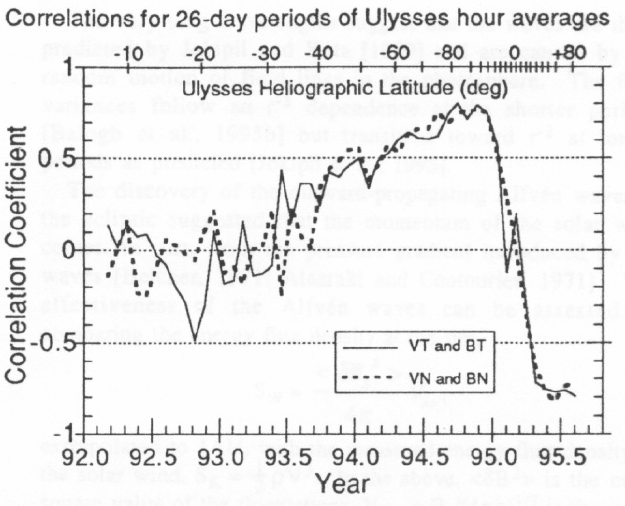
Figure 52: Magnetic field and velocity hourly correlation vs. heliographic latitude. Image reproduced by permission from Smith et al. (1995), copyright by